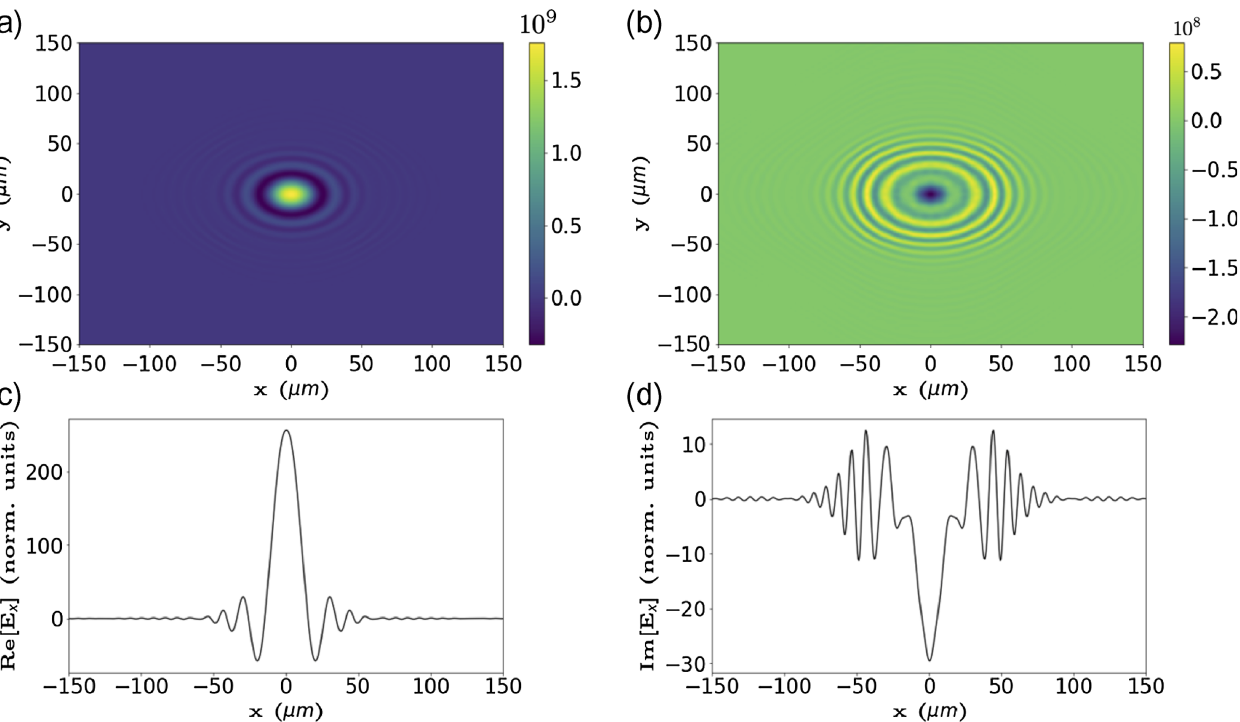
FIG. 8. Undulator radiation at first harmonic energy of 3.115 keV. (a) Real part of electric field. (b) Imaginary part of electric field. (c) Horizontal projection of real electric field. (d) Horizontal projection of imaginary electric